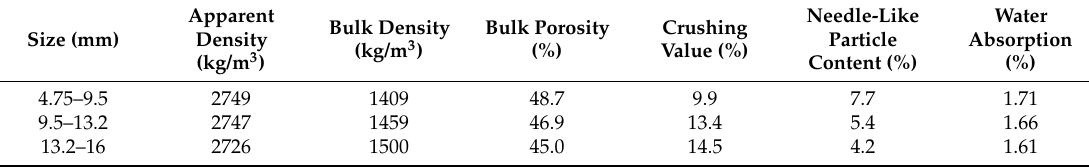
Table 2. Physical properties of natural granite coarse aggregate